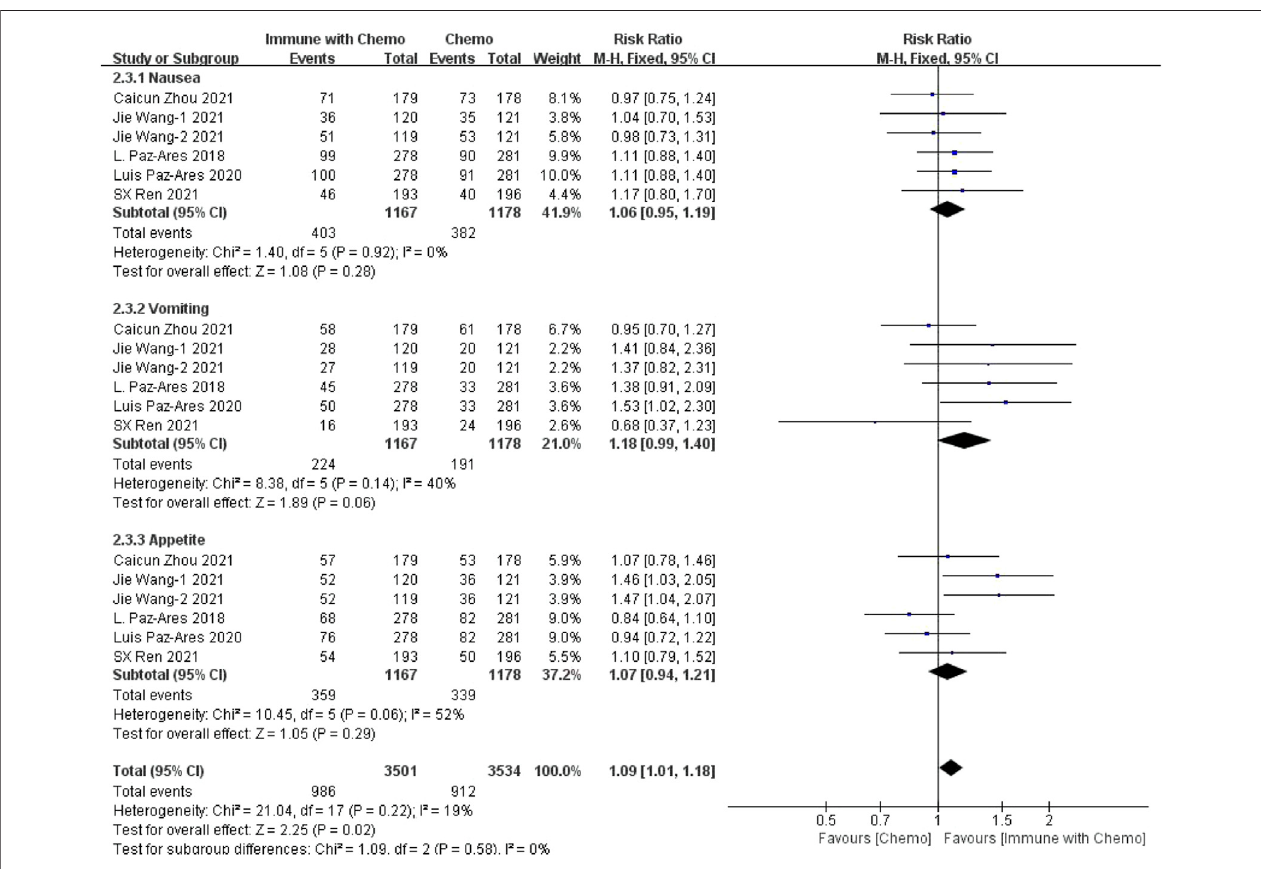
FIGURE 4 | Meta-analysis results of adverse reactions of any grade in gastrointestinal toxicity between the chemo with immune group and chemo group.